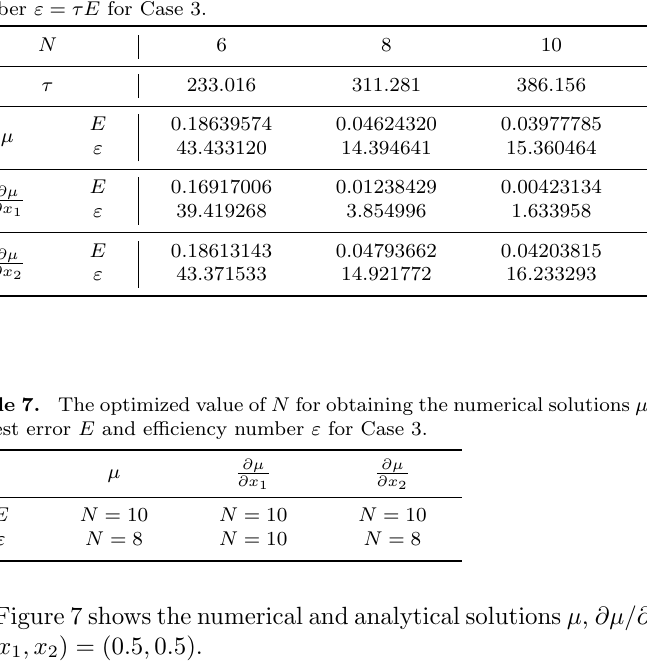
Figure 7 shows the numerical and analytical solutions µ , ∂µ/∂x 1 and ∂µ/∂x